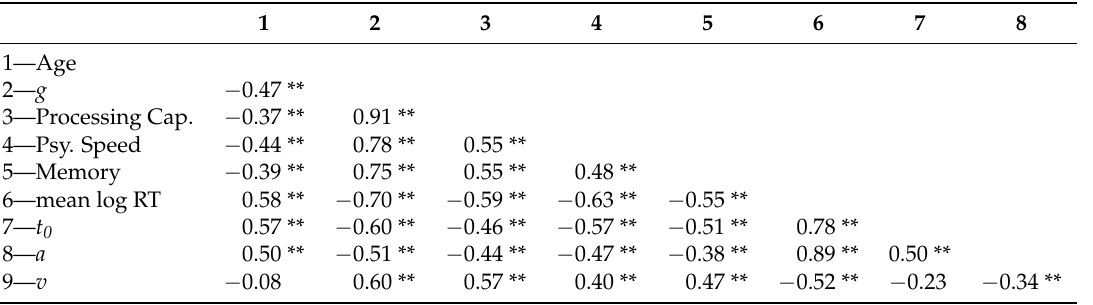
Table 5. Correlations of all the variables used for the general mediation